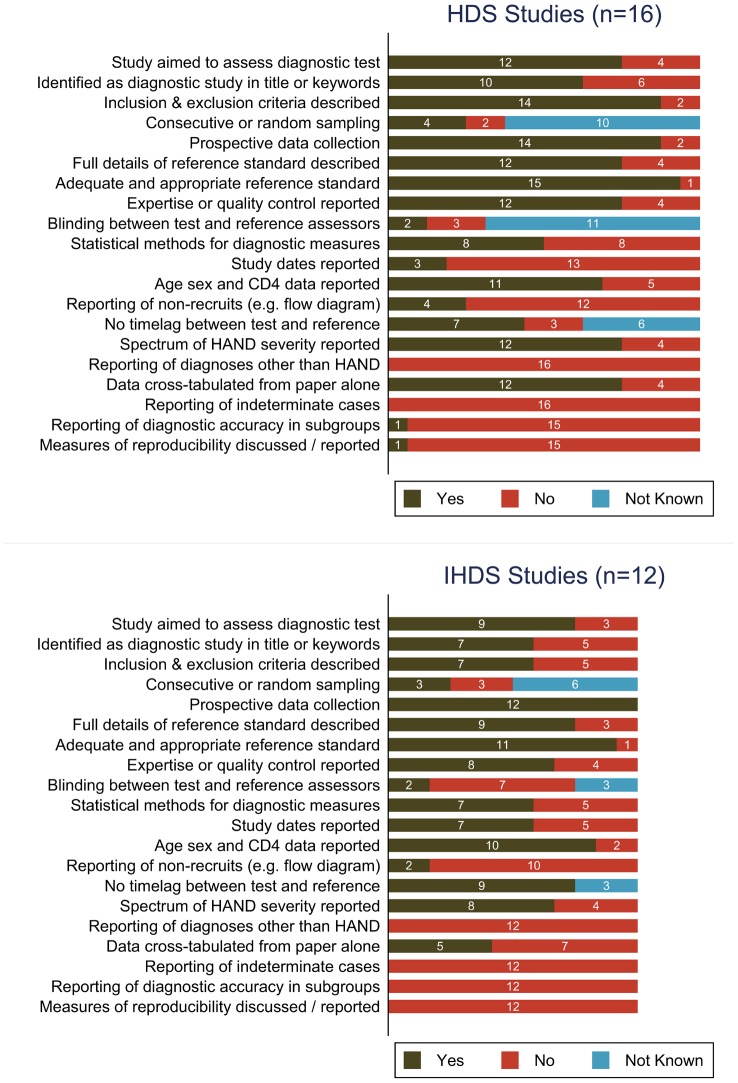
Methodology and reporting of reviewed studies: A, the HIV Dementia Scale; B, International HIV Dementia Scale.Olive-green bars indicate fulfilment of study quality criteria, red bars indicate non-fulfilment, and blue bars indicate that this feature was not reported or available from correspondence with the study author. The study by Skinner et al [13] applied both scales to the same patient sample and is represented in both graphs A and B. HAND: HIV-associated neurocognitive disorder.